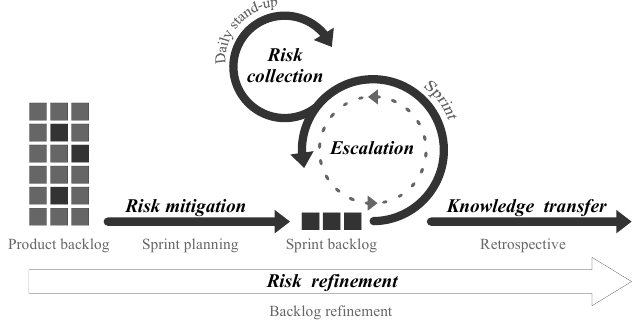
Figure 4. Overview of the framework steps and